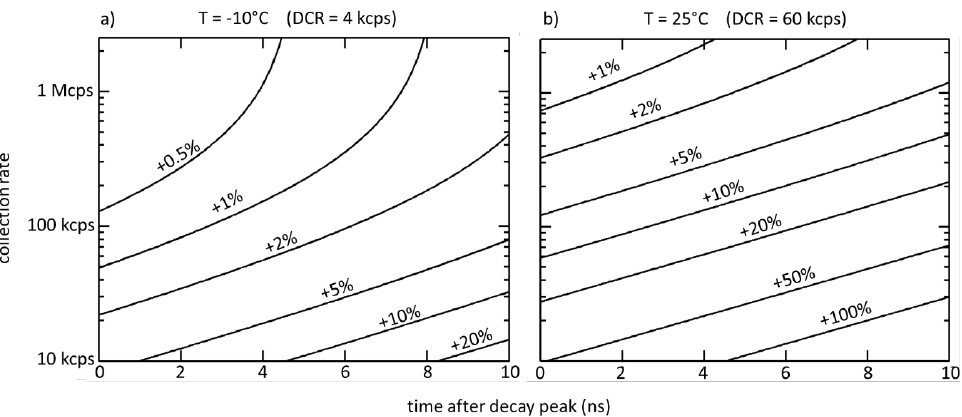
Figure 2. Increase in total noise along TCSPC histogram compared to shot noise alone for a 5 ns fluorescence decay at ( a ) T = −10 °C and ( b ) T = 25 °C. Contour lines indicate the increase in total noise in terms of percentage of the shot